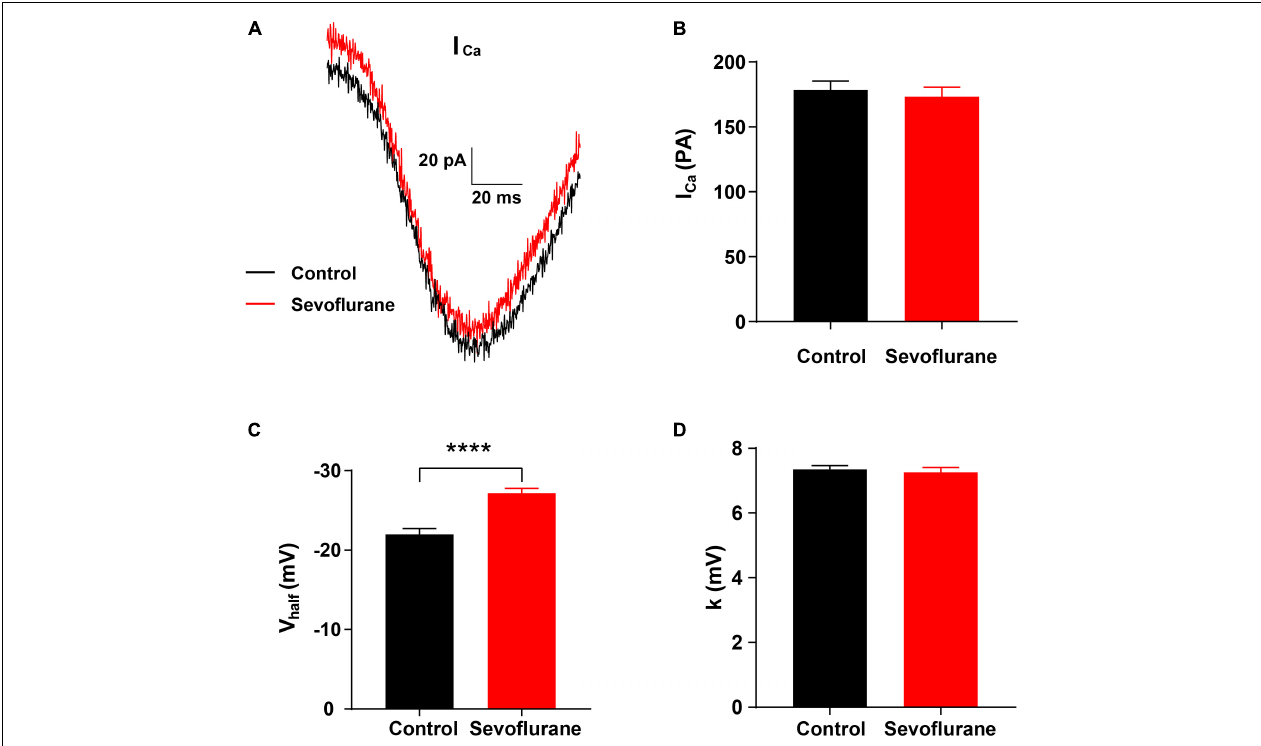
FIGURE 6 | Changes in Ca 2 + current in inner hair cells (IHCs) following sevoflurane exposure. (A) Representative Ca 2 + current in IHCs in the control (black) and sevoflurane (red) groups. (B) After multiple sevoflurane exposures during infancy, the peak amplitude of Ca 2 + current (I Ca ) of IHCs is similar to that in the control group. (C) The half-activation potential (V half ) is significantly more negative in the sevoflurane exposure group than that in the control group. (D) The slope of activation (k) is not significantly changed by multiple sevoflurane exposures in infancy ( n = 29 control group, n = 51 sevoflurane group). **** P < 0.0001, unpaired Student’s t -test in panels (B,C) , Mann–Whitney test in panel (D)